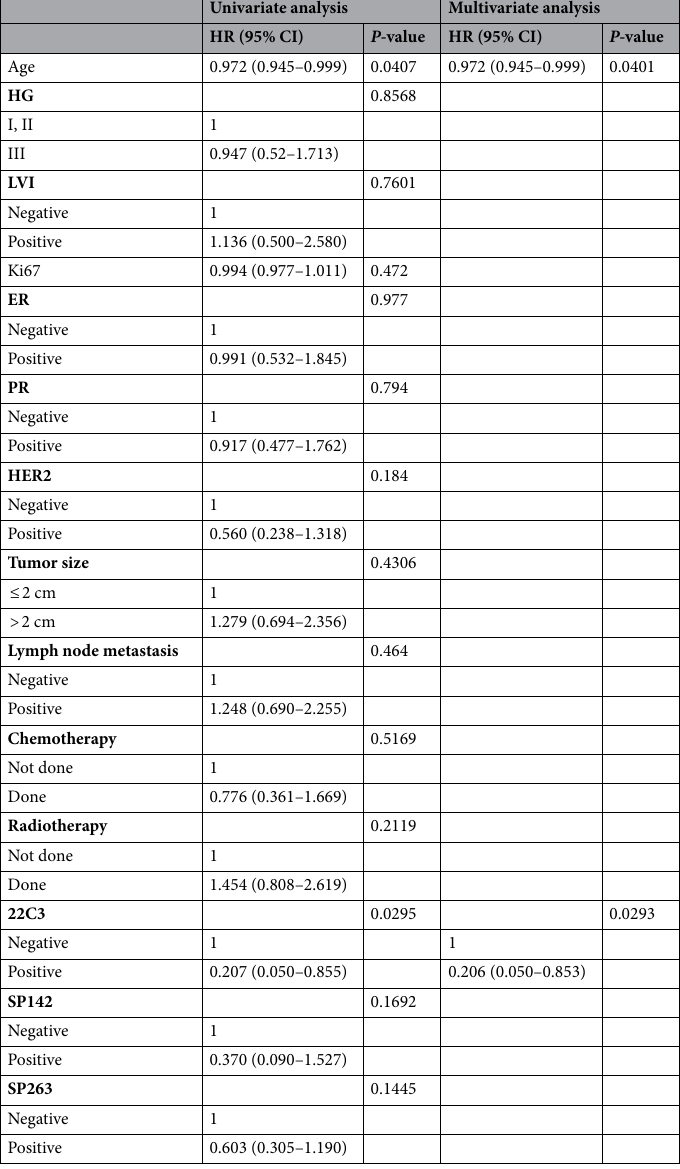
Table 2. Cox proportional hazard analysis for recurrence-free survival (RFS). HR, hazard ratio; CI, confidence interval; HG, histologic grade; LVI, lympho-vascular invasion; ER, estrogen receptor; PR, progesterone receptor; HER-2, human epidermal growth factor